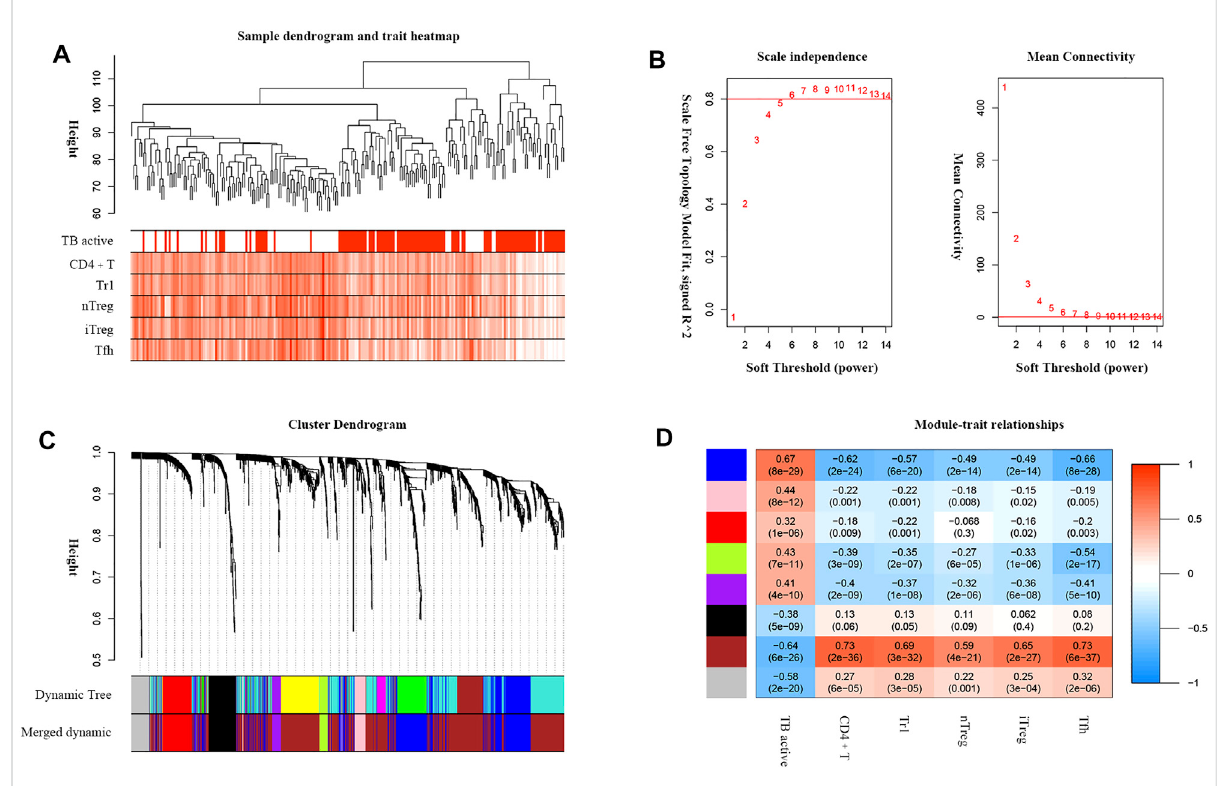
FIGURE 4 WGCNA analysis of DEGs associated with TB active status and critical T-cell abundance. (A) TB active status and T-cell abundance of samples clustered according to DEG expression. (B) Analysis of thenetwork topology for various soft-threshold powers. The auxiliary line on the longitudinal axisinthescale-freeR 2 showsavalueof0.8. (C) DendrogramofDEGsclusteredbasedonthemeasurement ofdissimilarity (1-TOM). (D) Heatmapof the correlations between the module eigengenes and the clinical traits. The numbers represent the correlation coef fi cients, with the corresponding p values indicated in